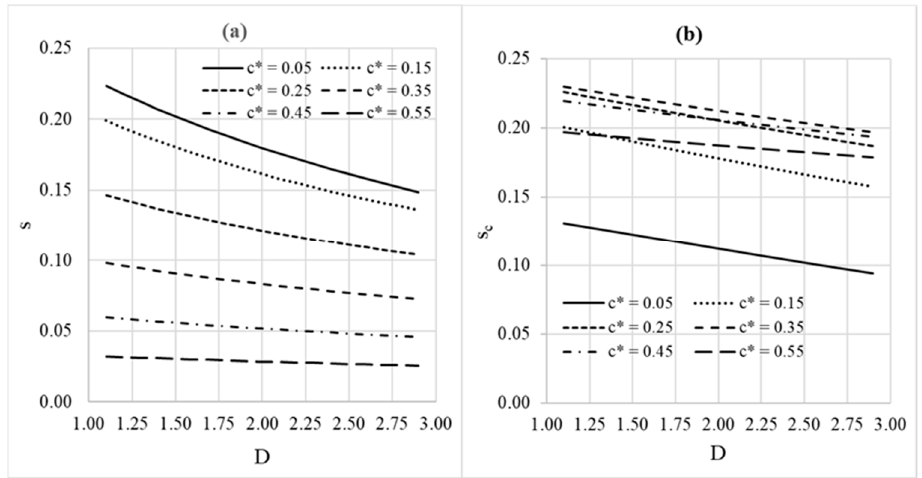
Figure 6. Impact of the fractal dimension D on the standard deviations of ( a ) the superficial velocity ratio s, and ( b ) the particle concentration s c .